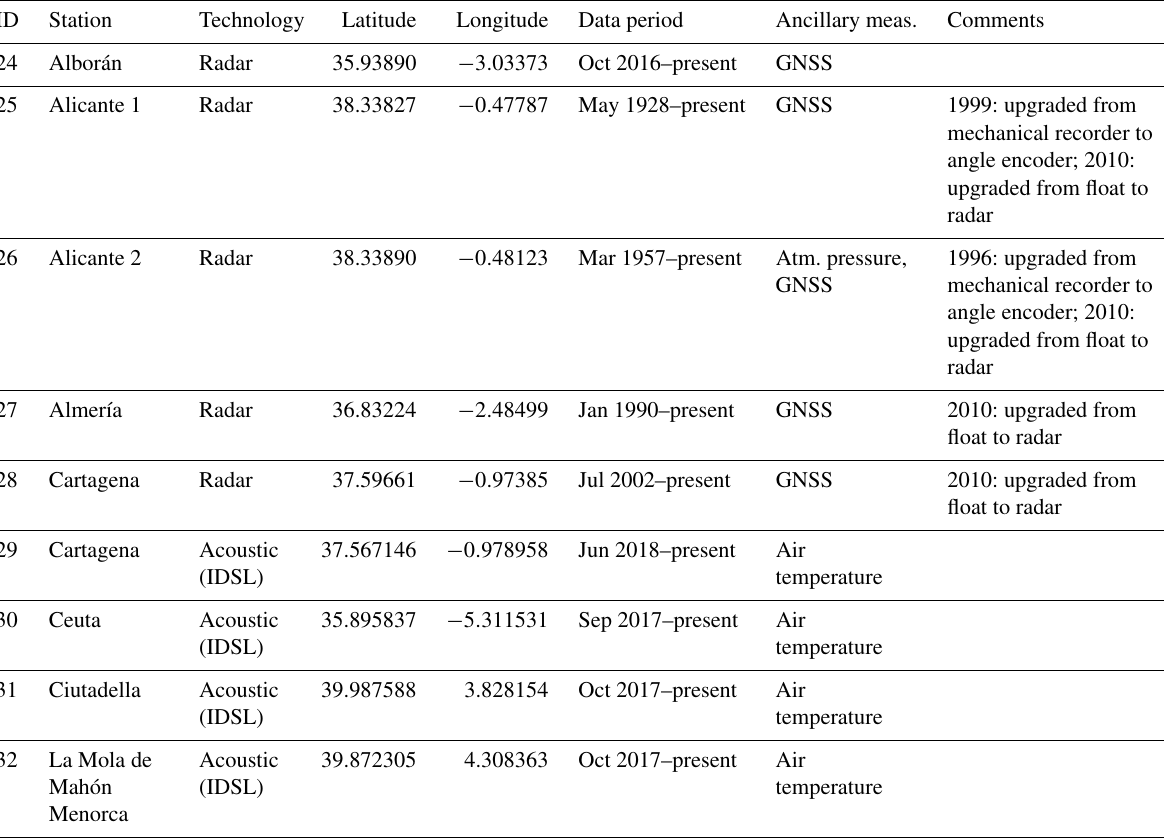
Table A3. Stations operated by National Geographic Institute of Spain in the Mediterranean Sea and data availability.